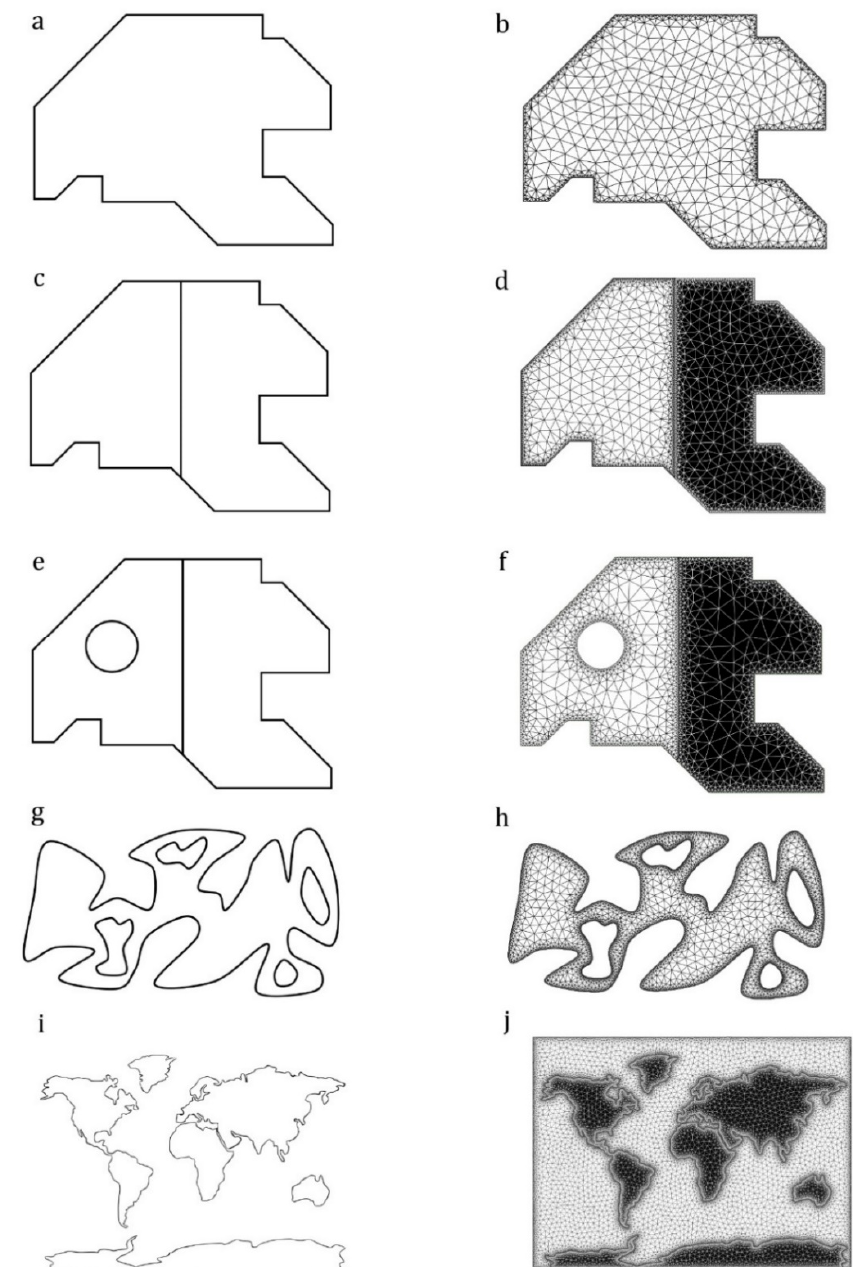
Figure 3. Modeling of in-plane domains. ( a ) Image of a simple in-plane domain. ( b ) The meshed model developed from the image in ( a ). ( c ) Image of an in-plane domain consisting of two subdomains. ( d ) The meshed model developed from the image in ( c ). ( e ) Image of an in-plane domain with two subdomains and a discontinuity. ( f ) The meshed model developed from the image in ( e ). ( g ) Image of an irregular-shaped domain with several discontinuities. ( h ) The meshed model developed from the image in ( g ). ( i ) Image of a complex-shaped in-plane domain with several subdomains. ( j ) The meshed model developed from the image in ( i ).